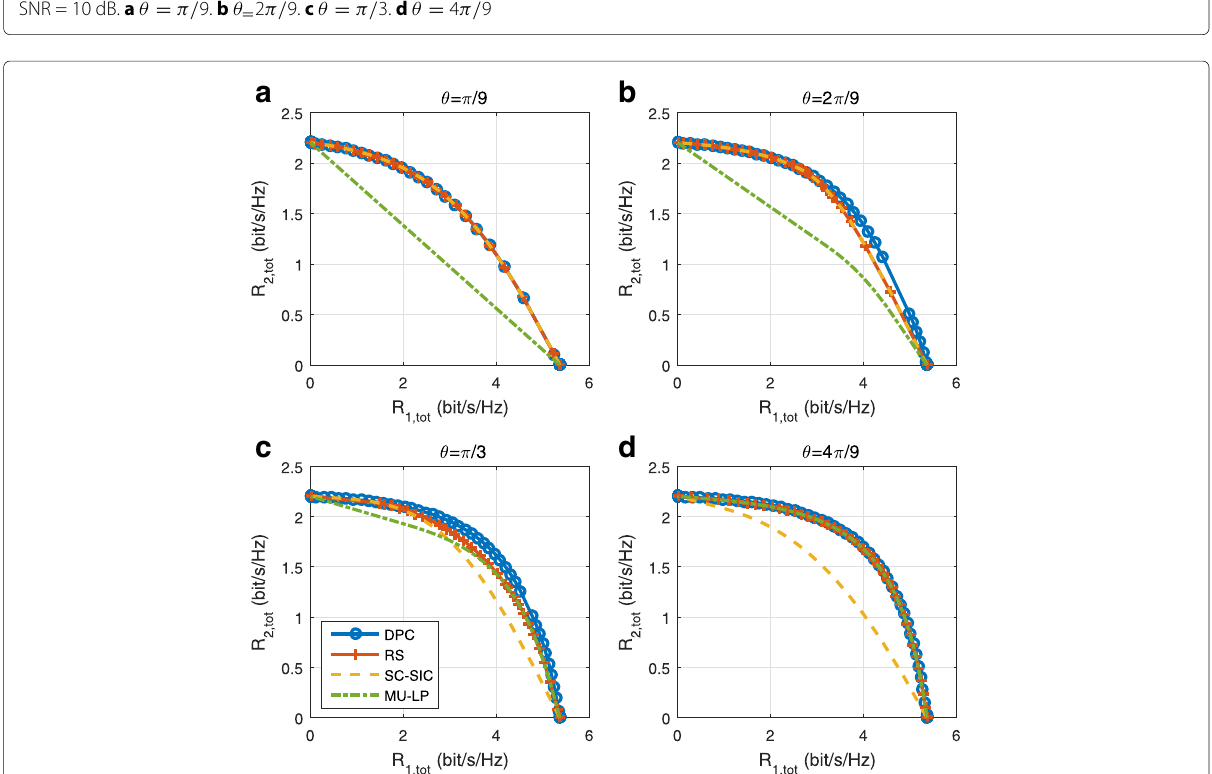
Fig. 24 Achievable rate region comparison of different strategies in perfect CSIT, γ = 0.3, N t = 4, SNR = 10 dB. a θ = π/ 9. b θ = 2 π/ 9. c θ = π/